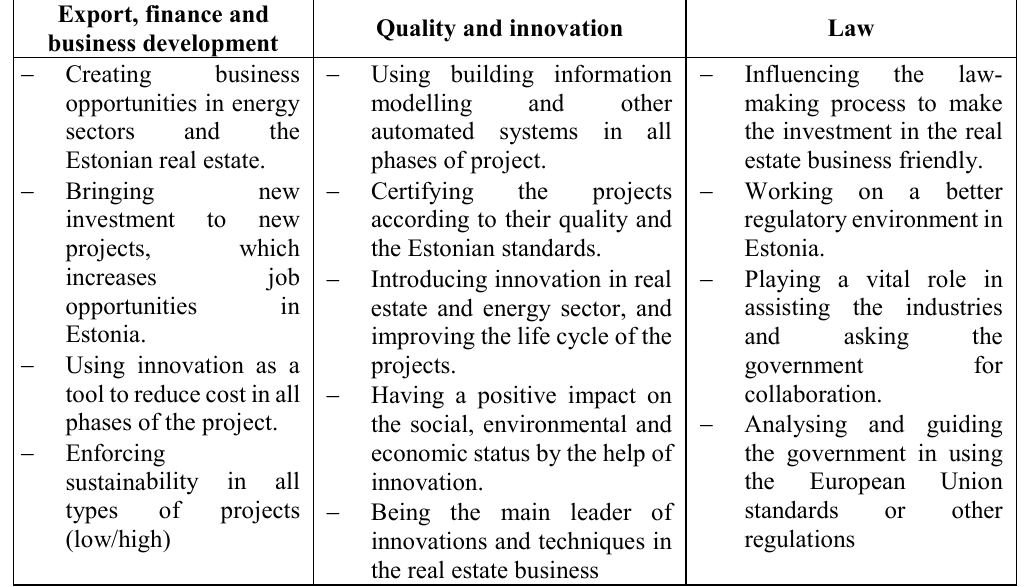
Table 8. EGBC Targets (Goals, Estonian Green Building Council, n.